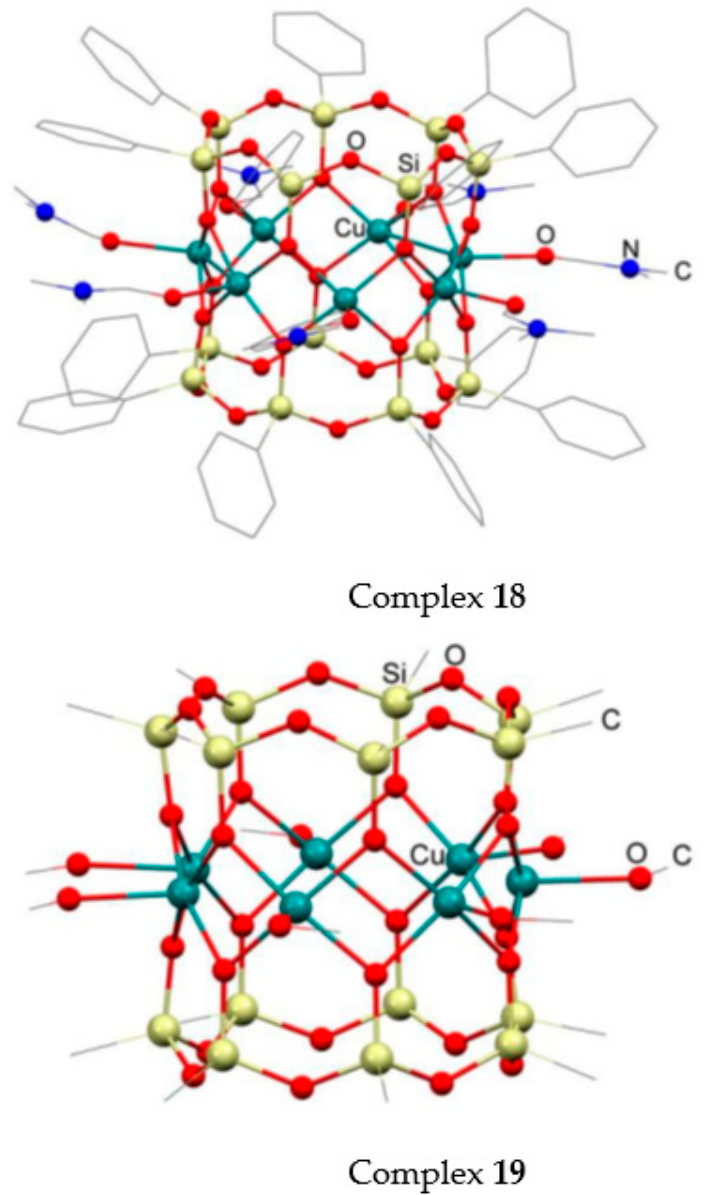
Figure 12. Molecular structures of 18 and 19 . Color code: Si—yellow, O—red, Cu—green, N—blue, adapted from [81] Copyright (2018) with permission from Wiley.